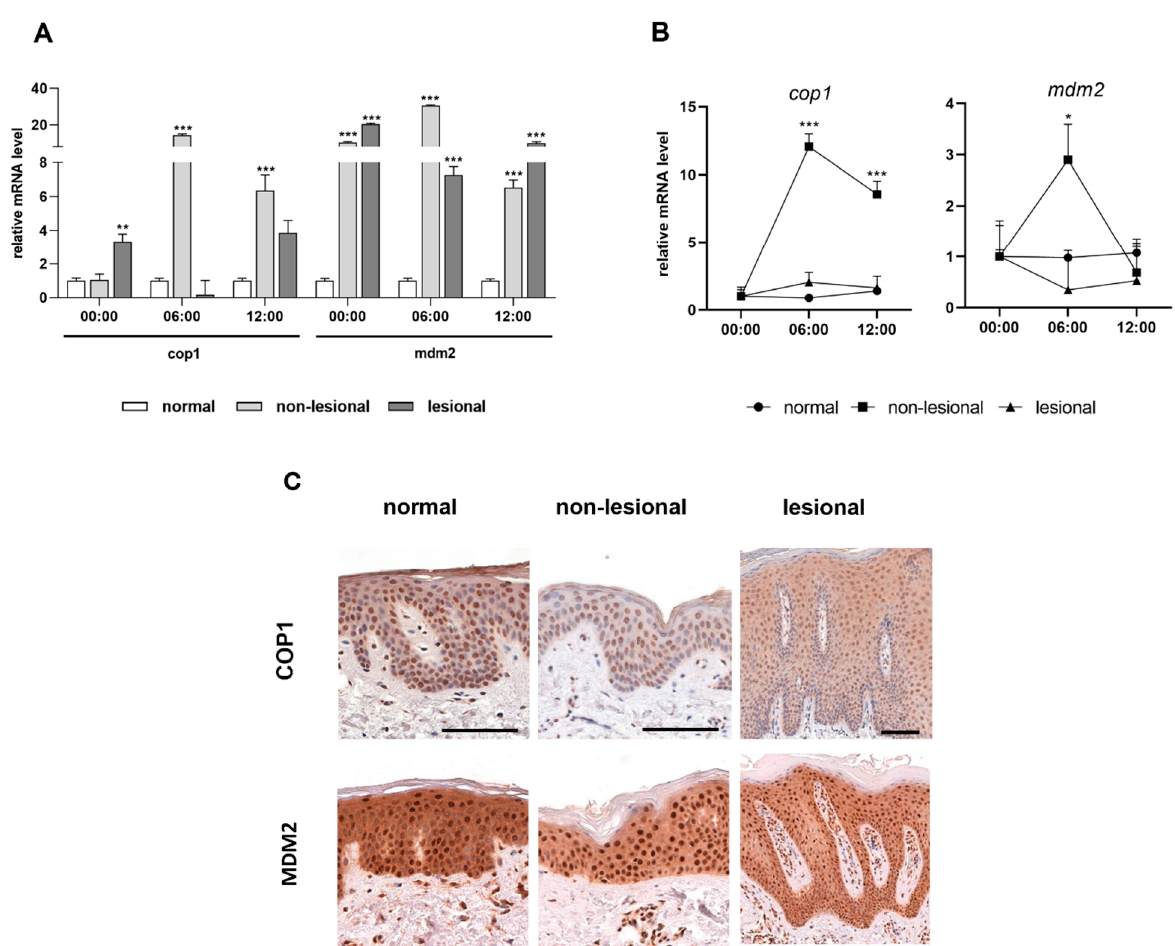
Figure 4. Expression levels of the cell cycle regulators in psoriasis . ( A ) Relative mRNA expression of cop1 ( left ) and mdm2 ( right ) genes at three time points. ( B ) Daily changes of mRNA expression of cop1 ( left ) and mdm2 ( right ) genes. Significant differences assessed by two-way ANOVA followed by Turkey’s post hoc test between the time points: * p < 0.05; ** p < 0.005; *** p <0.0005. Data are presented as the means ± SEM. ( C ) Representative DAB-stained skin sections at 06:00.